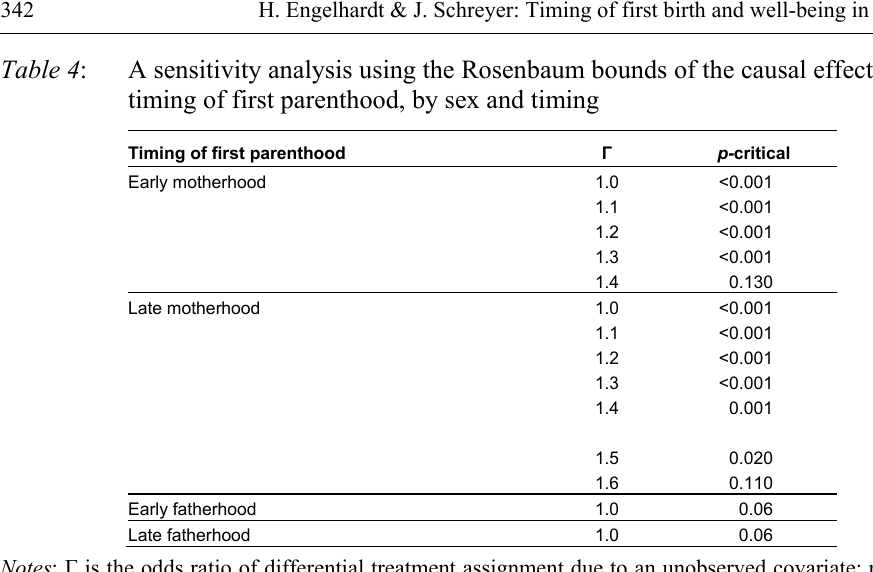
1.1 <0.001 1.2 <0.001 1.3 <0.001 1.4 0.130 1.1 <0.001 1.2 <0.001 1.3 <0.001 1.4 0.001 1.5 0.020 1.6 0.110